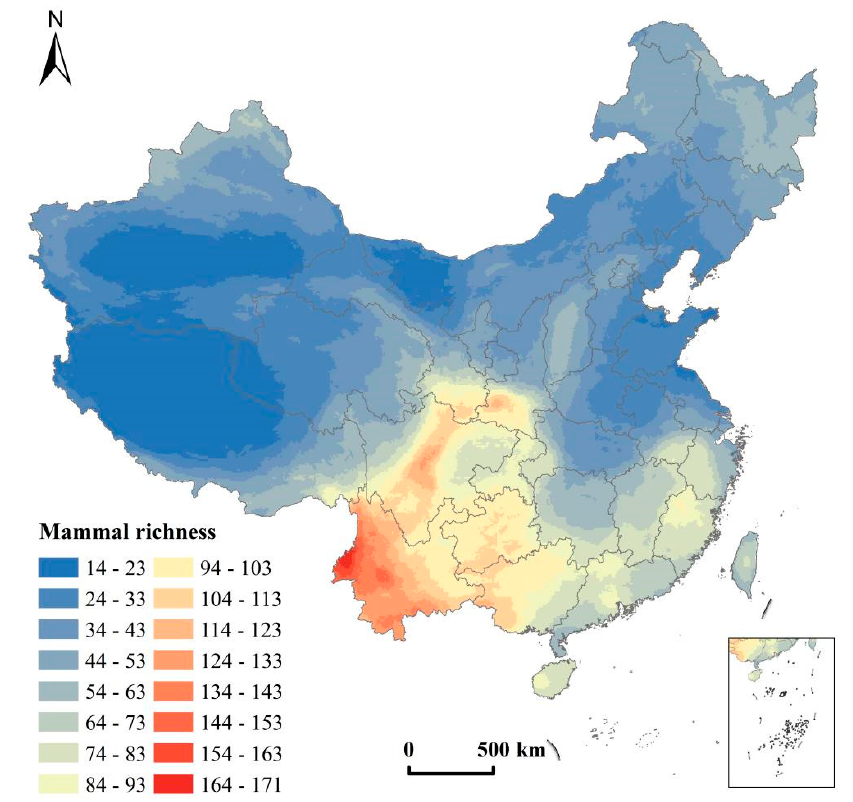
Figure 3. Distribution pattern of terrestrial mammal richness in China.